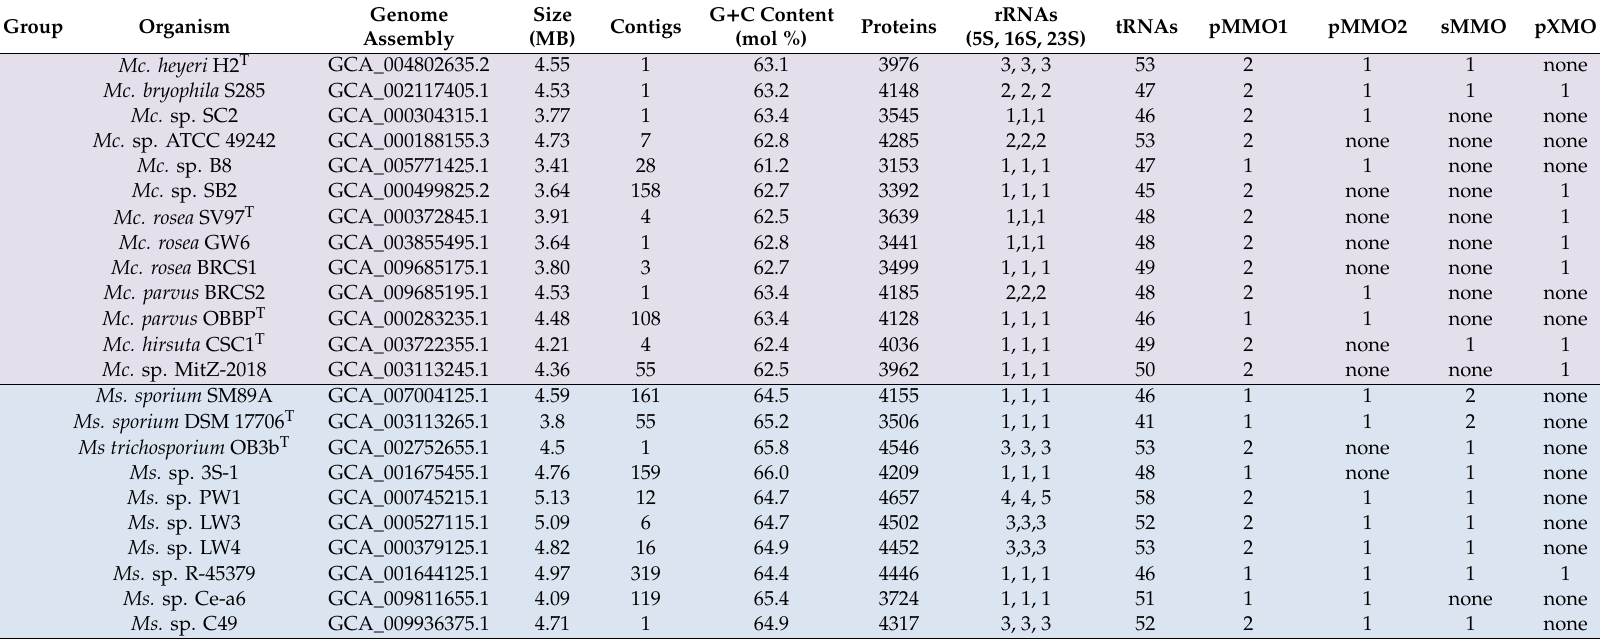
Table 1. General features of the genomes of Methylocystis and Methylosinus species selected for the analysis. Methylocystis and Methylosinus genomes are highlighted by purple and blue,